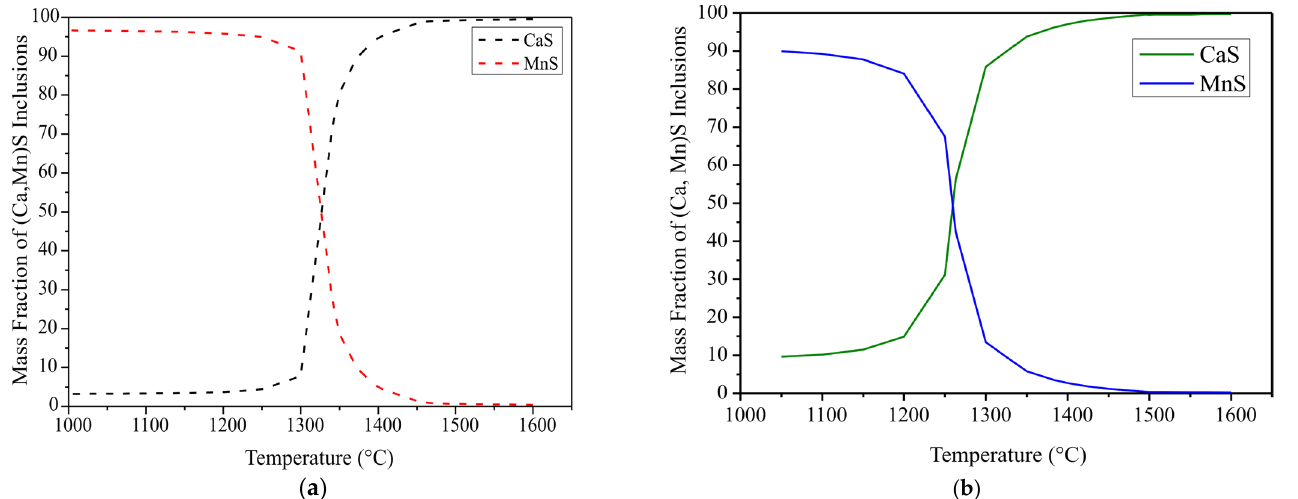
Figure 7. Mass percentage of CaS and MnS in the solid solution of (Ca,Mn)S. ( a ) GS1 sample, ( b ) GS2 Sample.